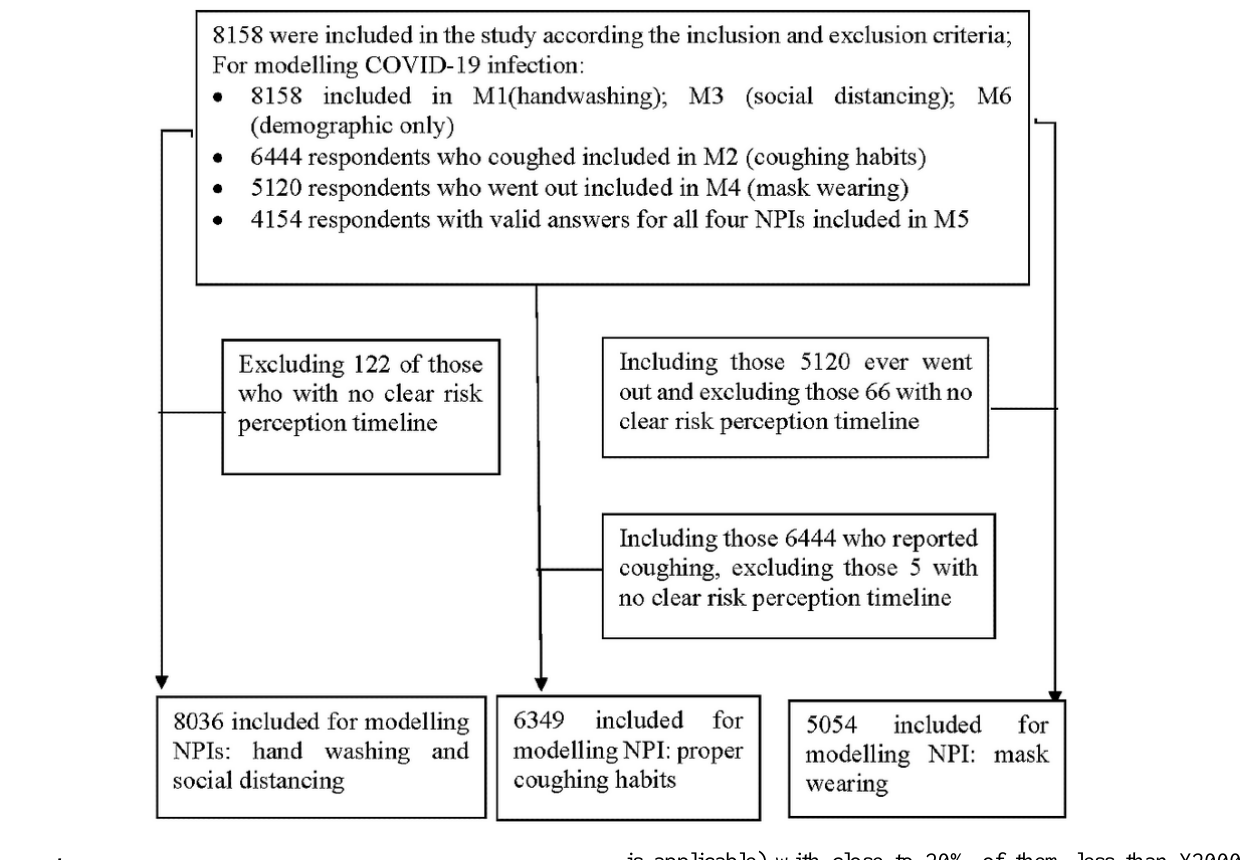
Figure 1. A flowchart of sample sizes for the modeling of the four NPIs (Multimedia Appendix 2: eTable 1) and COVID-19 infection (Tables 5 and 6). M: model; NPI: nonpharmaceutical